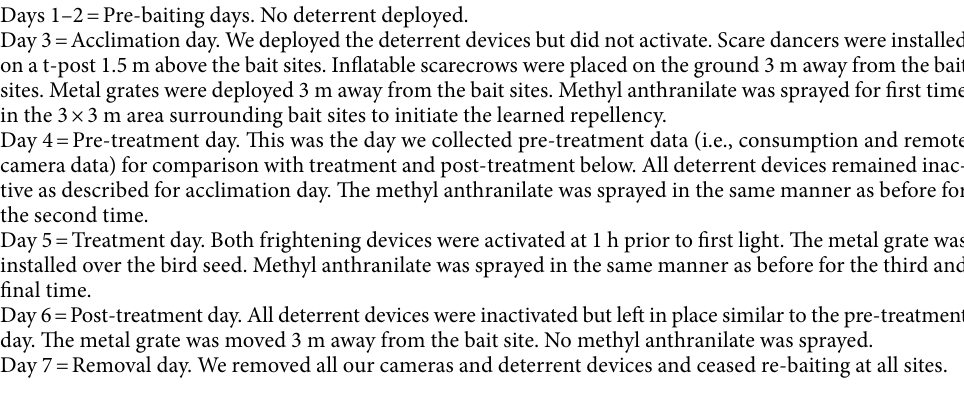
For each site, we calculated an index of the number of passerine birds observed in each two-min time-lapse image (rate = average number of birds/two mins) during morning hours (i.e., 0500–1200) for the morning of pre-treatment, treatment, and post-treatment. We compared indices among each of the 3 days and five treat- ments using negative binomial mixed models and log-links with package glmmTMB 37 in Program R v3.6.3 38 . We